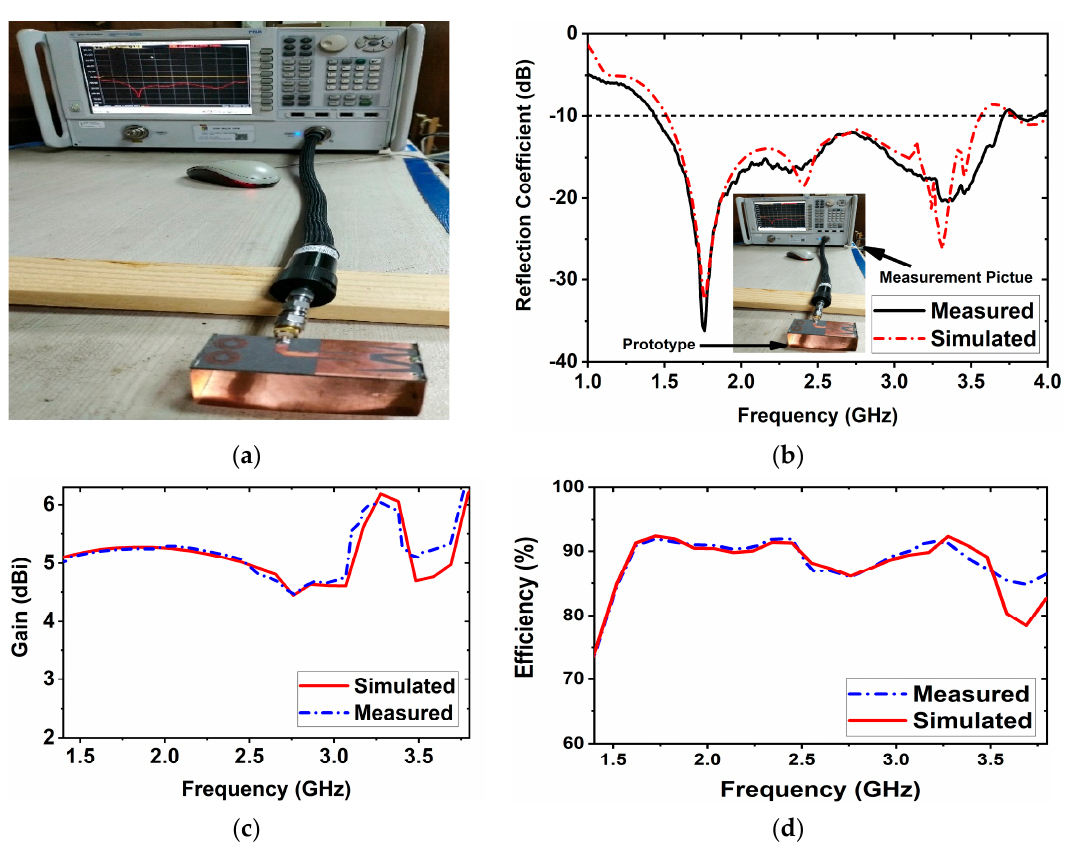
Figure 3. Measurement setup and resultant outcomes of the antenna sensor ( a ) PNA setup, ( b ) measured and simulated reflection coefficient, ( c ) gain, ( d ) efficiency.